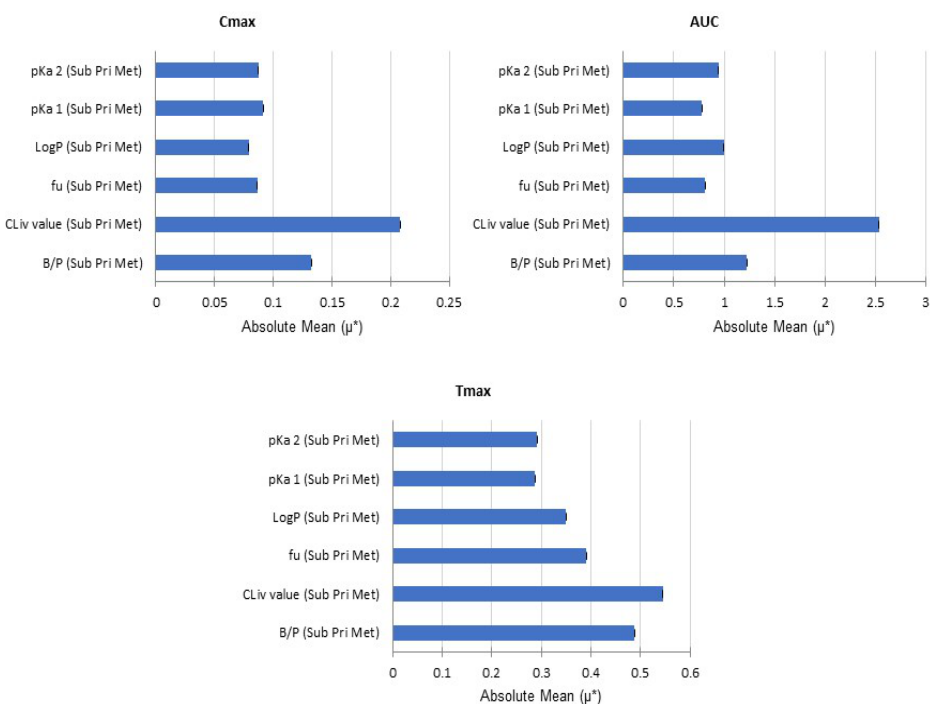
Figure 4. Results of sensitivity analysis for antazoline metabolite model parameters. µ *—the mean of absolute elementary effects of the tested parameter.